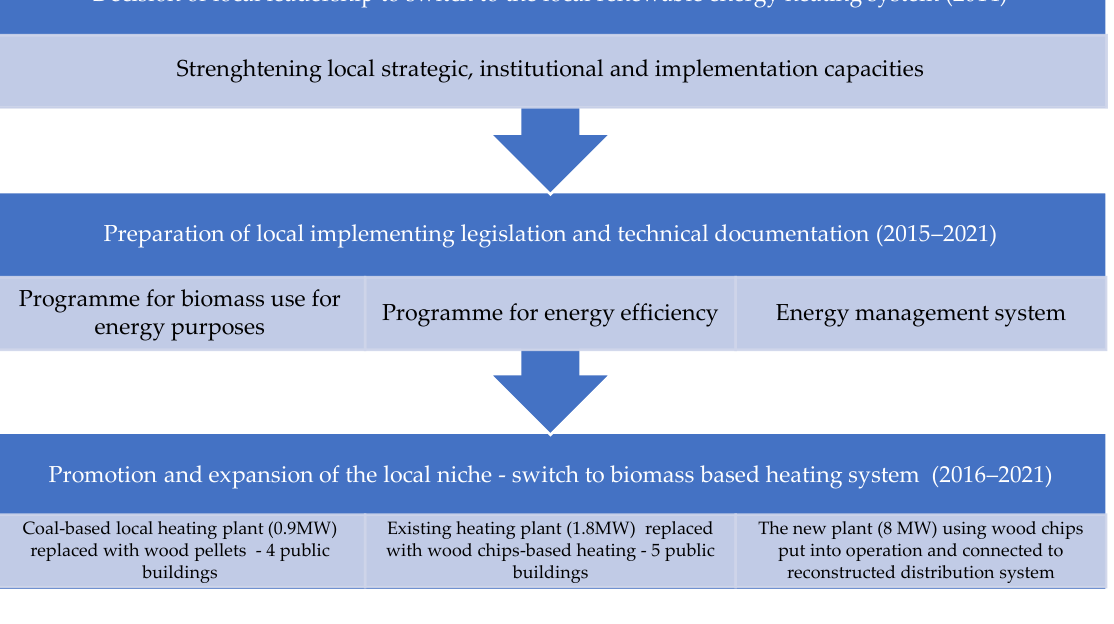
Figure 7. Implementation stages of local leadership decision that was set in 2014 to switch to a renewable energy heating system.